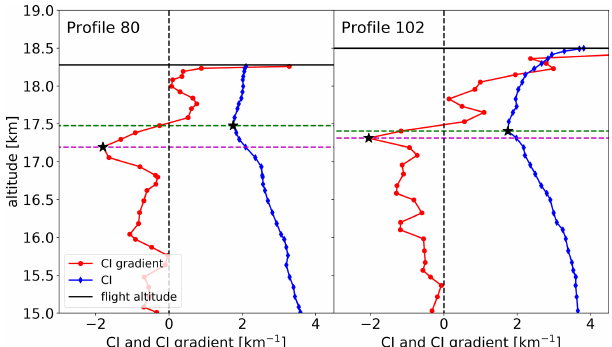
Figure 10. Altitude profiles of the cloud index (CI) and the CI gra- dient for two selected profiles of the CRISTA-NF measurements during RECONCILE flight 3. The CI is shown as a blue curve, and the CI gradient is shown as red curve. The flight altitude is marked by a horizontal black line. The dashed green and magenta lines show the minima of the CI and CI gradient profile